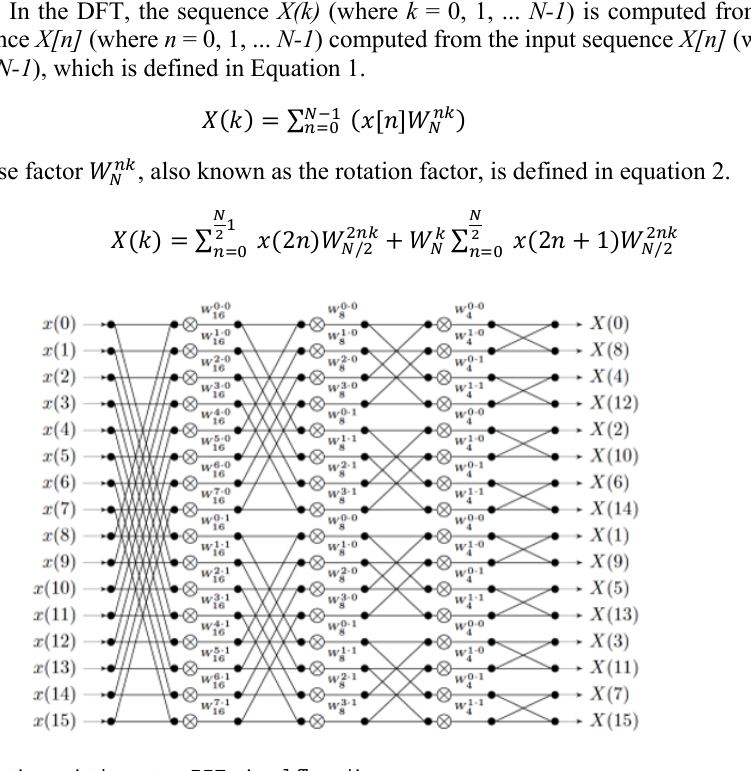
Fig. 1. 16 floating point base-two-FFT signal flow